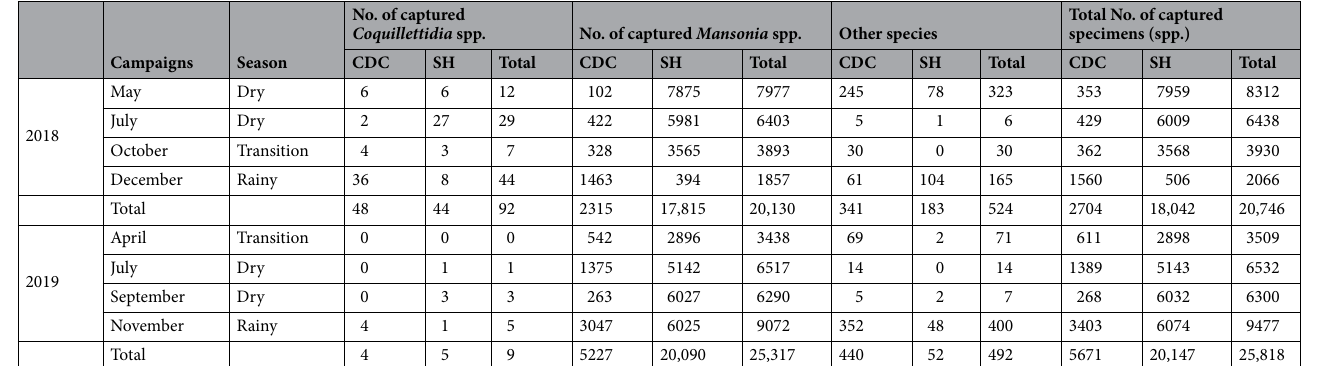
Table 2. Abundance of adults of Mansonia spp., Coquillettidia spp., and other species captured using CDC and Shannon (SH) light traps near the Jirau hydroelectric plant in Rondônia state, Brazil, in 2018 and 2019.